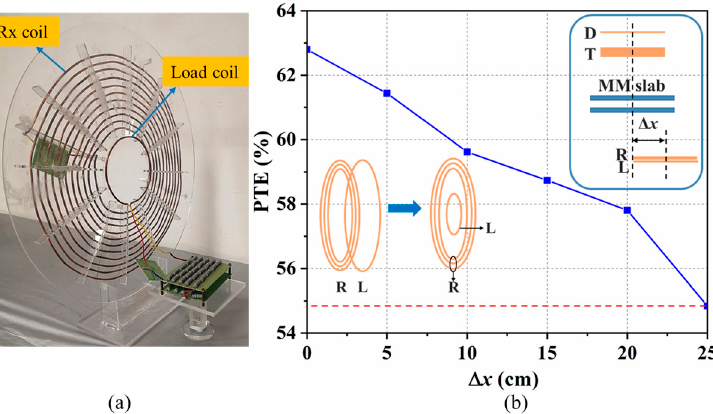
Figure 11. ( a ) The setup of Rx and load coils. ( b ) Measured PTE as a function of the Δ x .